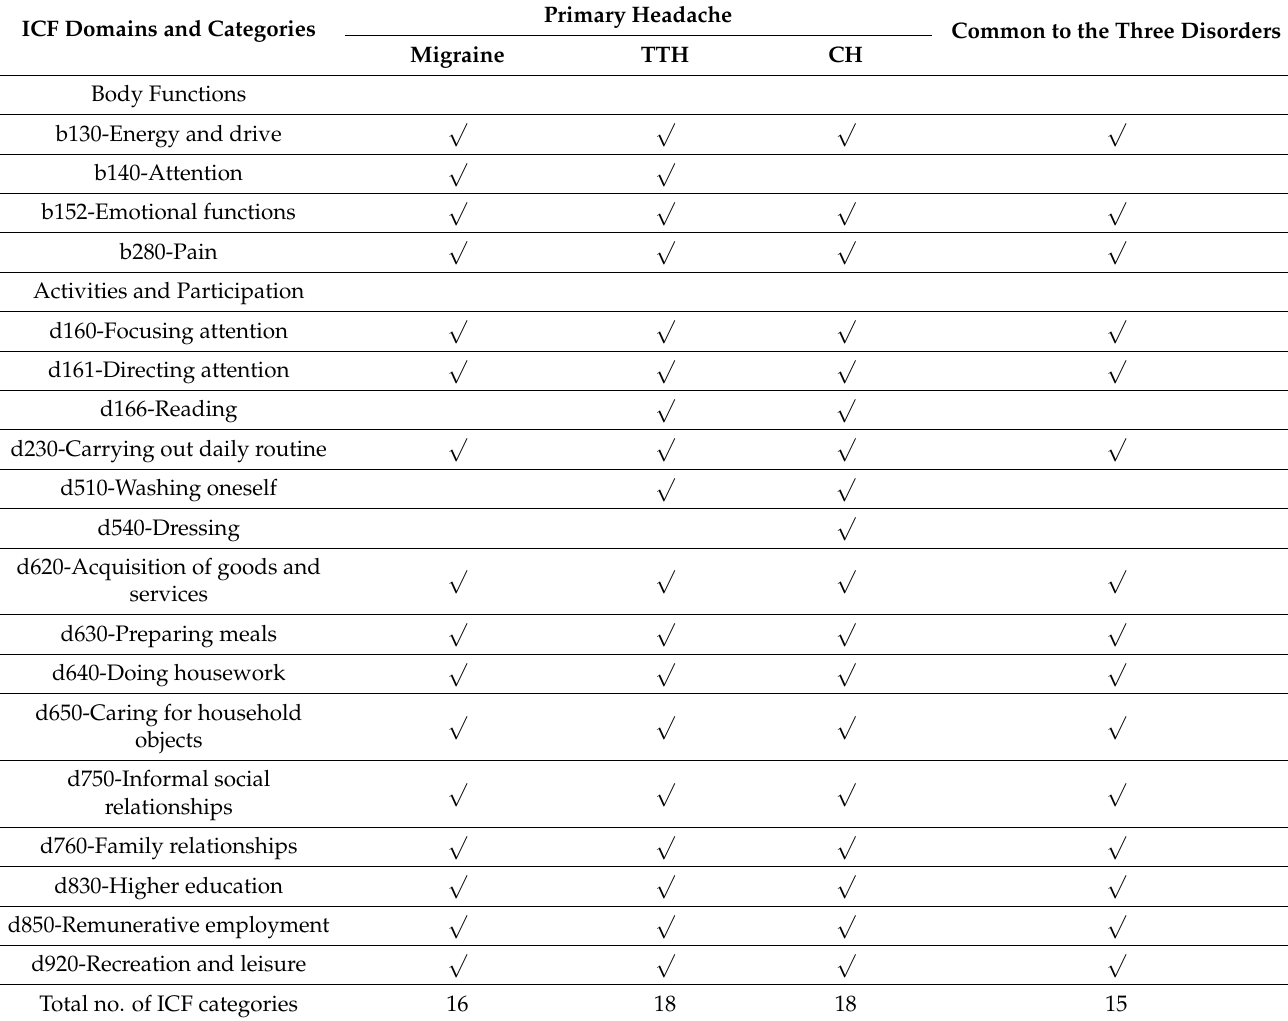
Table 3. Common and disease-specific elements of functioning covered by the assessment